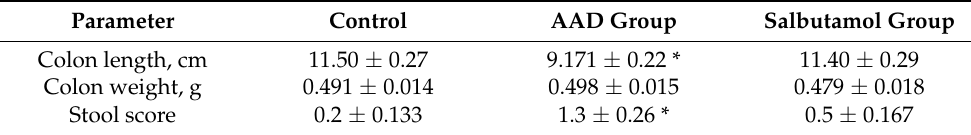
Table 1. Colonic changes, including the measured colon length, colon weight, stool score, were an- alyzed as described in Materials and Methods. Data are presented as a mean ± standard deviation (n = 10 per group, * p < 0.05 vs control, ANOVA).